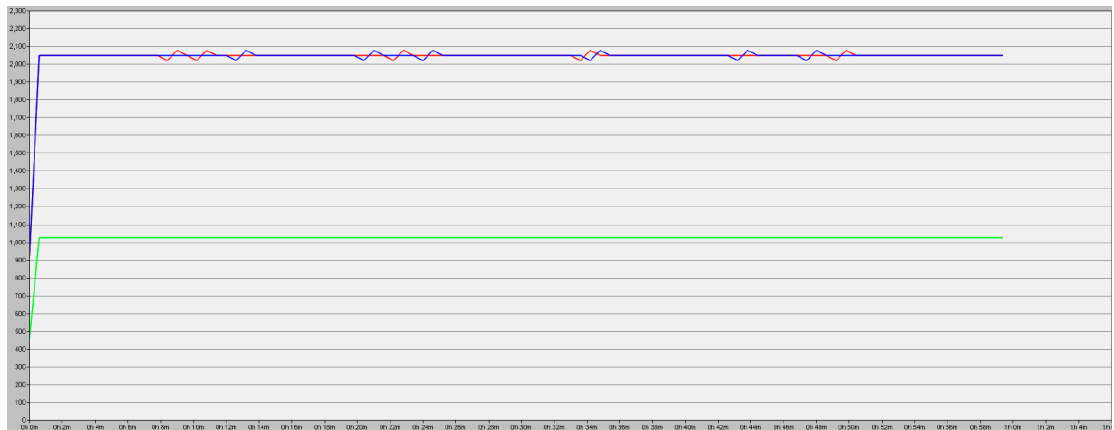
Figure 7. Improvement of Energy Efficiency (1). (X axis: Time, Y axis: Energy efficiency).